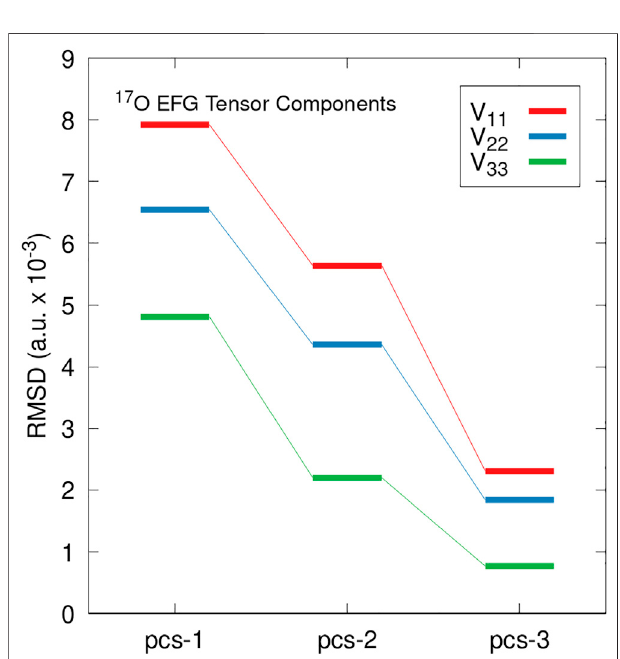
FIGURE 2 | RMS deviations in predicted EFG tensor principal components relative to PBE0/pcs-4 calculations. Deviations in the | V 33 | component are shown in red, | V 22 | in blue, and | V 11 | in green. Values are reported in atomic units with a scaling factor of 10 – 3